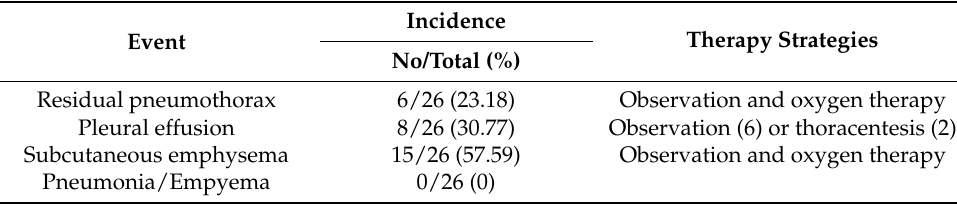
Table 3. Early postoperative complication among the drainless